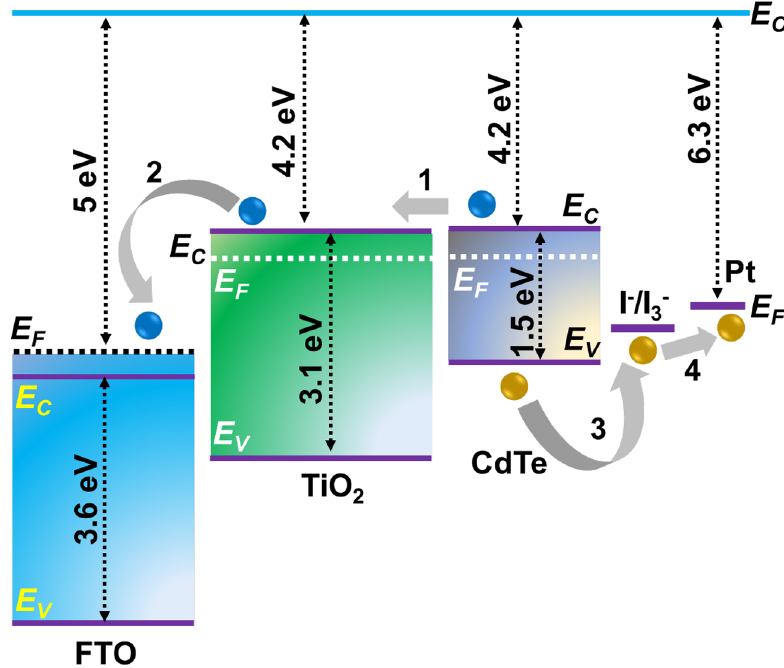
Fig. 6 Energy-level representa- tion and the charge transport processes at the interfaces of FTO/TiO 2 /CdTe/electrolyte/Pt